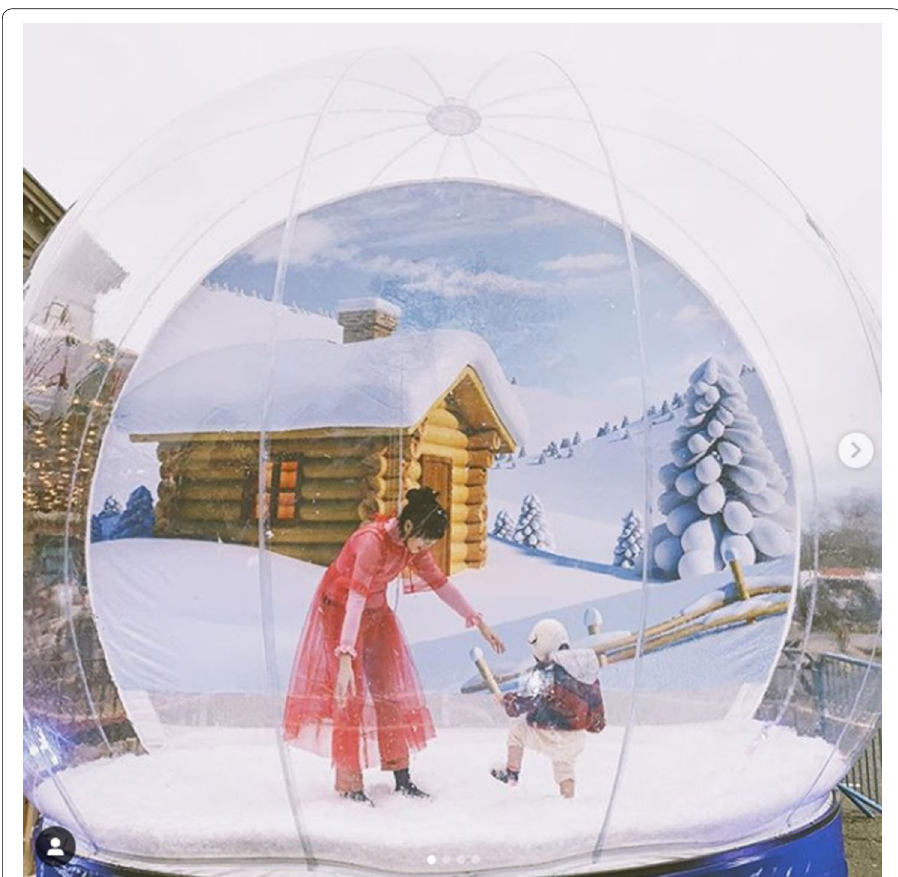
Fig. 14 Alexandra Palace. https ://www.insta gram.com/p/BrIjn NqBl_u/. Accessed 3 October